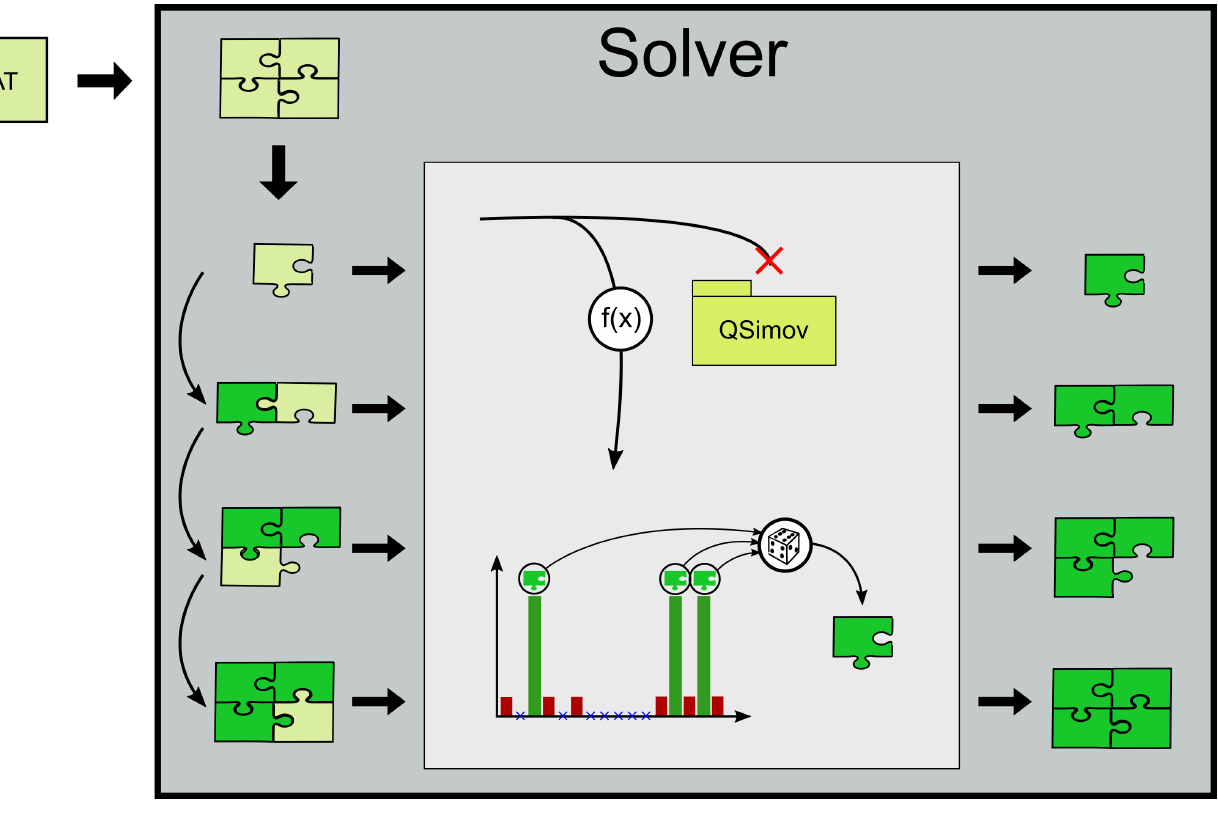
Figure 1. Solver diagram. Algorithm 1 Algorithm to extend the set of